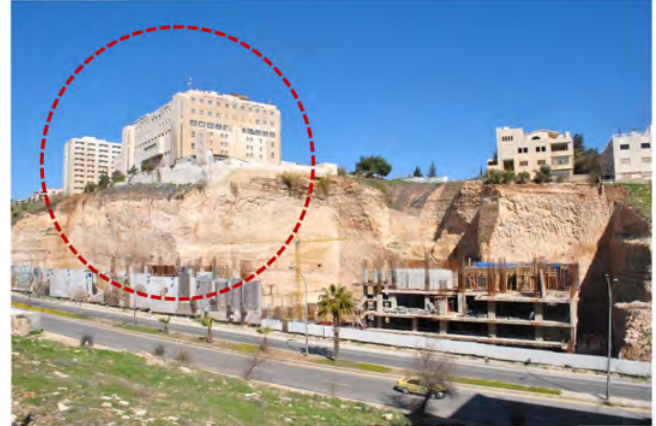
Figure 20. The current situation of the Living Wall project site. Source: Project: Manifesto, Holes on hold competition